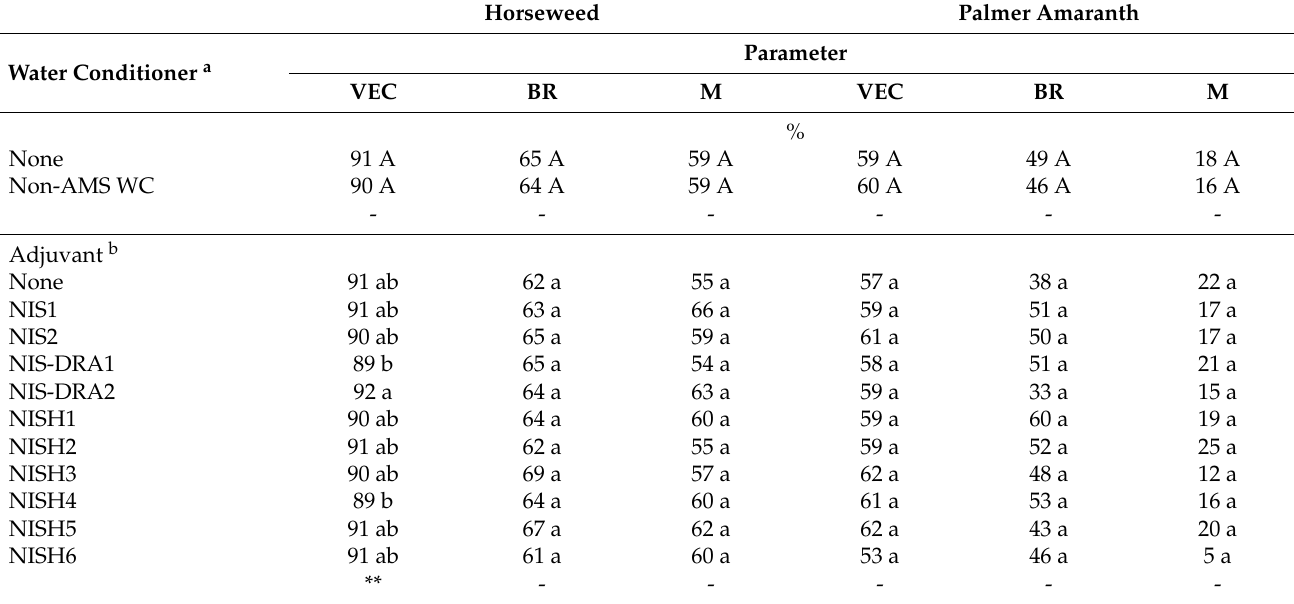
Means followed by the same letter in the column do not differ using Tukey’s test at α = 0.05. Significance levels: -, nonsignificant at α =